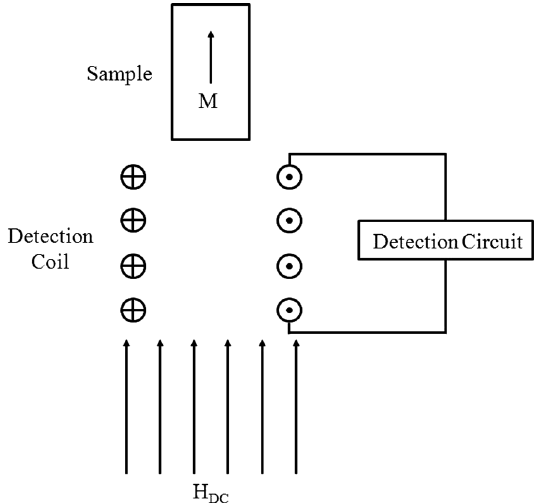
FIG. 4. Schematic diagram of the magnetization measurement setup. For the measurements on the electron beam welded niobium samples, the orientation of the weld bead was parallel to the plane of the paper.